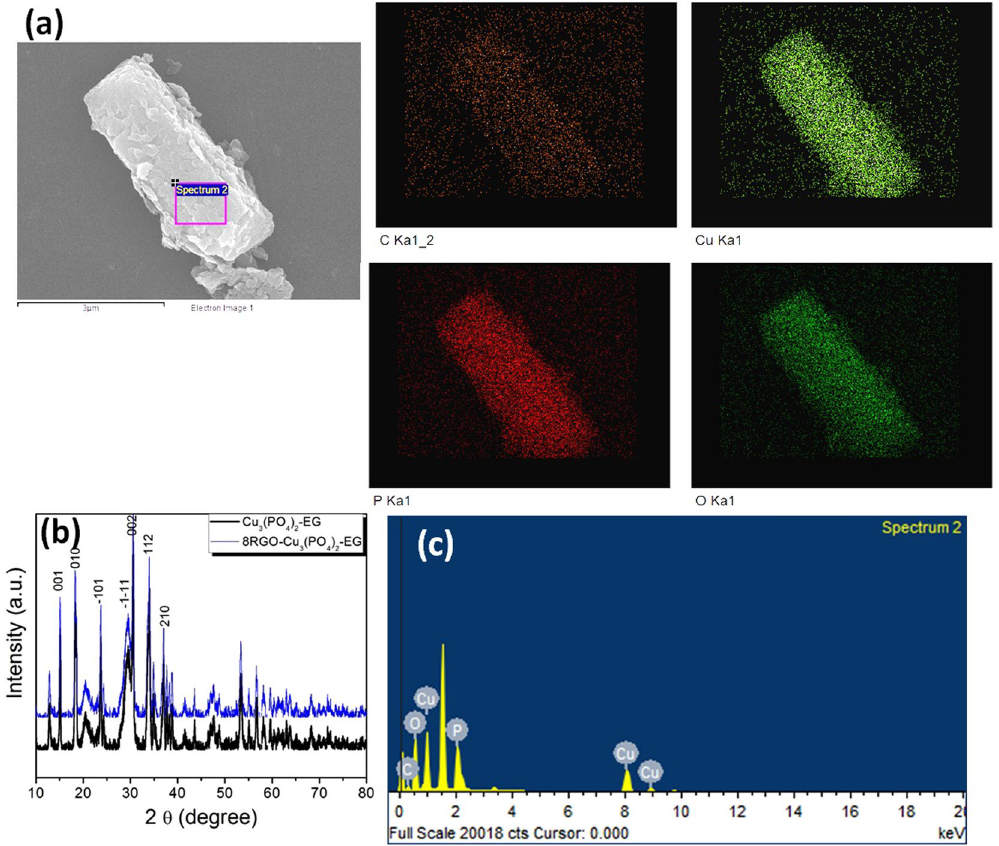
Figure 2. ( a ) The x-ray mapping of elements present in 8RGO-Cu 3 (PO 4 ) 2 -EG. ( b ) XRD pattern of 8RGO- Cu 3 (PO 4 ) 2 -EG and Cu 3 (PO 4 ) 2 -EG samples. ( c ) EDX data of 8RGO-Cu 3 (PO 4 ) 2 -EG collected by rastering the incident electron beam on the selected area with elemental